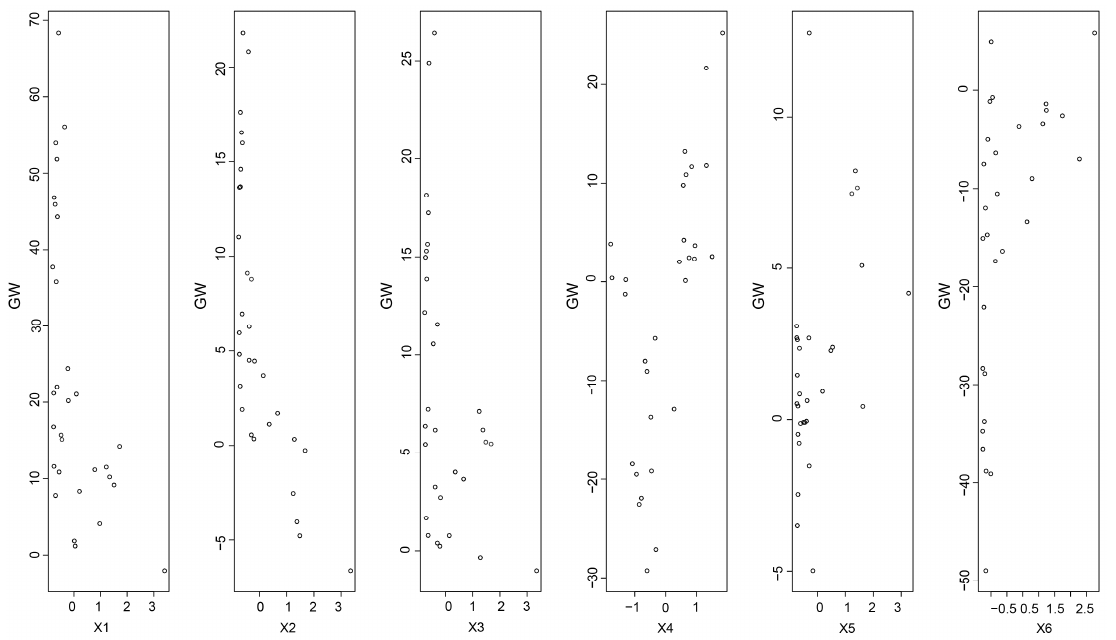
Figure 8. The GW of different input factors’ contribution to the predicted output IHC (X1: root length; X2: root projected area; X3: root surface area; X4: root average diameter; X5: root volume; X6: root biomass).